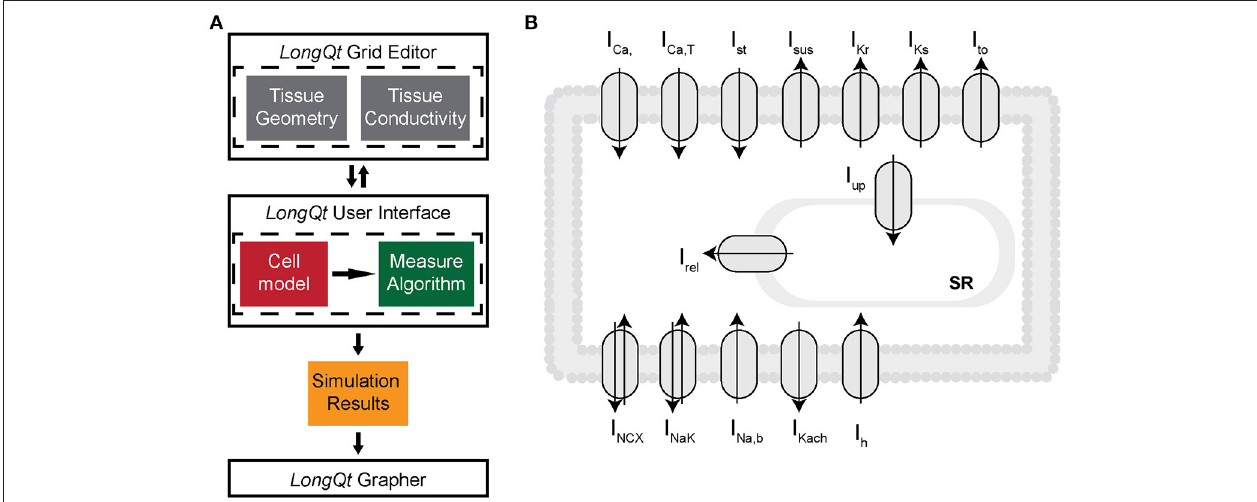
FIGURE 1 | (A) LongQT simulation software uses an object-oriented design where a “Cell” class describes the workings of an individual cell, i.e., Rabbit SAN cell vs. Human Ventricular cell. Cell classes then are used by “Protocol” classes to define what type of simulation is being run on the cell. This could be a simulation with constant stimulus or periodic stimulus. Simulations of fiber and grid tissue require additional objects that go between Protocols and Cells to define properties of the tissue like its geometry and conductivity. Finally there is a ”Measure” class which tracks values such as Peak Voltage or Ca 2 + minimum. (B) Schematic diagram of the rabbit SAN cell model, which includes mathematical representations of ion currents important for generating the sinoatrial node cell action potential: L-type and T-type Ca 2 + currents ( I CaL and I CaT ), Rapid and slow components of the delayed rectifier K + currents ( I Kr and I Ks ), 4AP-sensitive transient outward and sustained K + currents ( I to and I Sus ), acetylcholine-sensitive K + current ( I Kach ), Hyperpolarization-activated funny current ( I h ), Na + /Ca 2 + exchanger ( I NCX ), Na + /K + pump ( I NaK ), and Ca 2 + signaling uptake (j up ) into the network sarcoplasmic reticulum (NSR), transfer (j tr ) into the junctional SR (JSR), and release (j rel ) into the